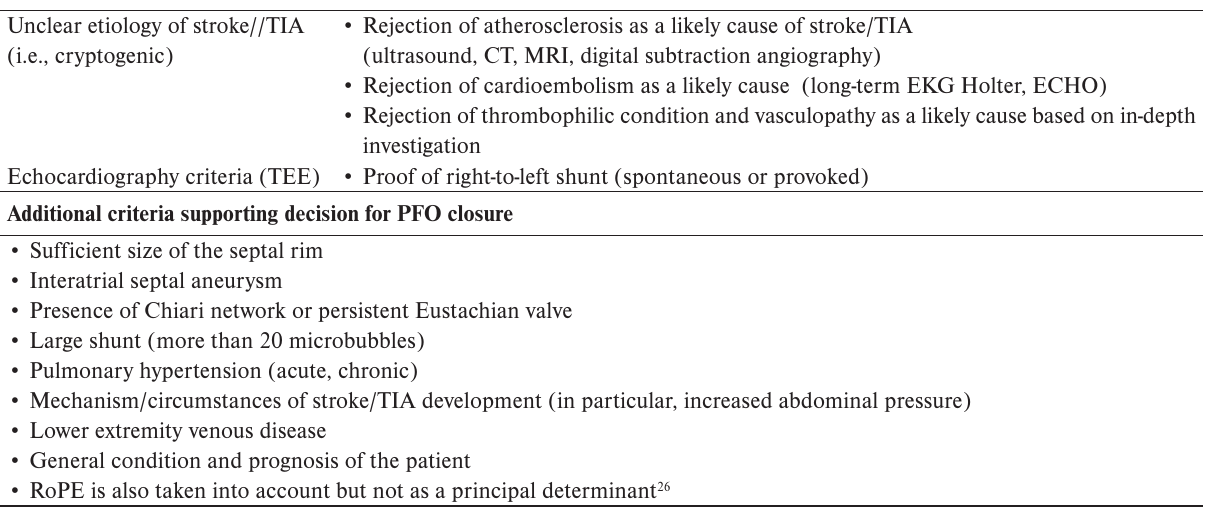
Table 2. Indication criteria for interventional PFO closure at our department. Basic criteria for referring the patient for PFO closure Unclear etiology of stroke//TIA